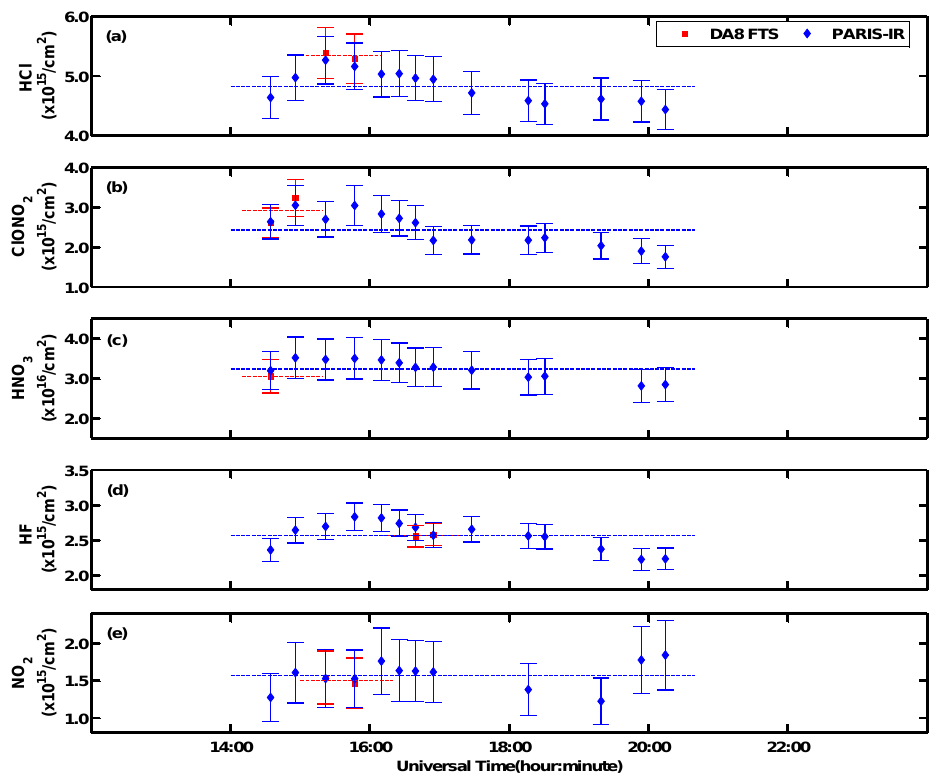
Fig. 4. Total vertical column densities of HCl (a) , ClONO 2 (b) , HNO 3 (MW 868) (c) , HF (d) , and NO 2 (e) retrieved from spectra obtained with PARIS-IR and the DA8 FTS at PEARL on 5 March 2006. Error bars indicate the DA8 FTS and PARIS-IR total percentage errors given in Table 2. Red dashed lines and blue dashed lines indicate the daily mean total column densities measured by the DA8 FTS (red squares) and PARIS-IR (blue diamonds),